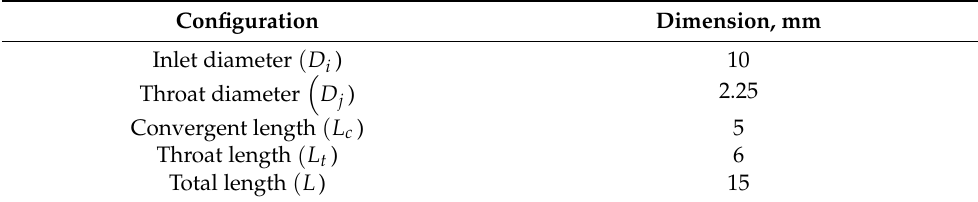
Table 1. Main dimensions of the converging-barrel